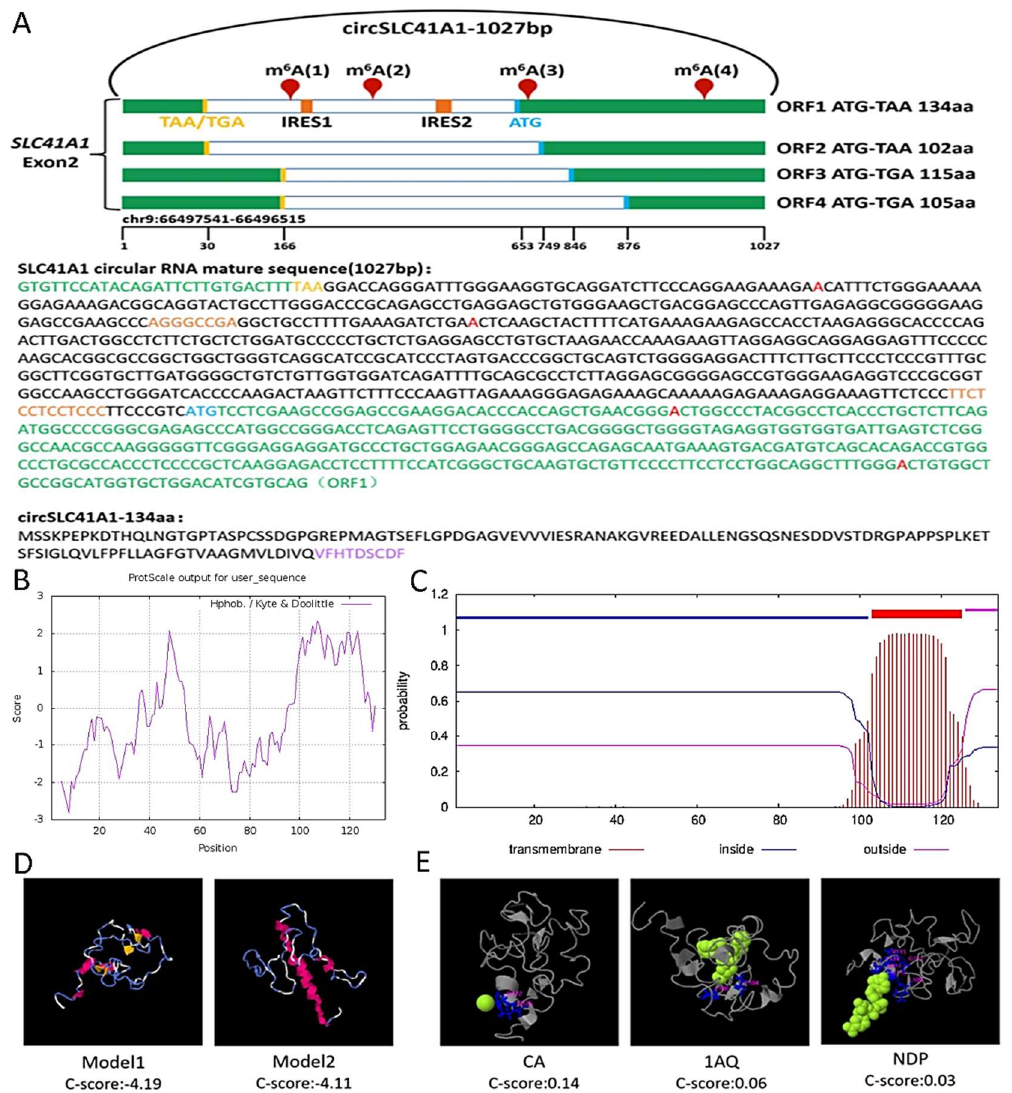
Figure 7. Evaluation of the coding ability of circSLC41A1. ( A ) Upper panel: the putative open reading frame (ORF) in circSLC41A1. Note that the circSLC41A1 junction is inside the ORF1. Lower panel: the sequences of the putative ORF are shown in green, internal ribosomal entrance site (IRES) sequences are shown in orange, the potential m 6 A site is shown in red, and specific amino acid sequences of ORF1 are shown in purple. ( B ) Hydrophobicity analysis of circSLC41A1−134aa. The ordinate score greater than 0 indicates hydrophobicity and less than 0 indicates hydrophilicity. ( C ) The transmembrane domain prediction of circSLC41A1−134aa. The transmembrane domain is shown in red, the intramembranous region is shown in blue, and the extramembranous region is shown in fuchsia. ( D ) The tertiary structure prediction of circSLC41A1−134aa. α−helix, β−sheet, and a random coil are shown in red, blue, and yellow, respectively. ( E ) The ligand prediction of 134aa. The green segments represent ligands and red segments represent the binding